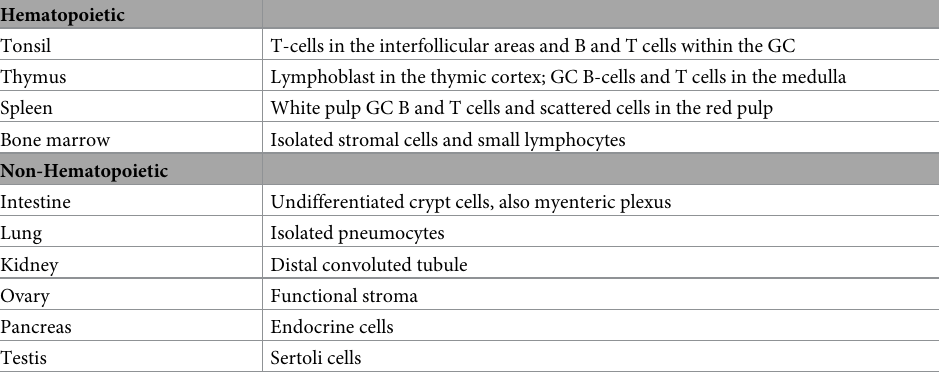
Table 1. Expression of TOX in normal human